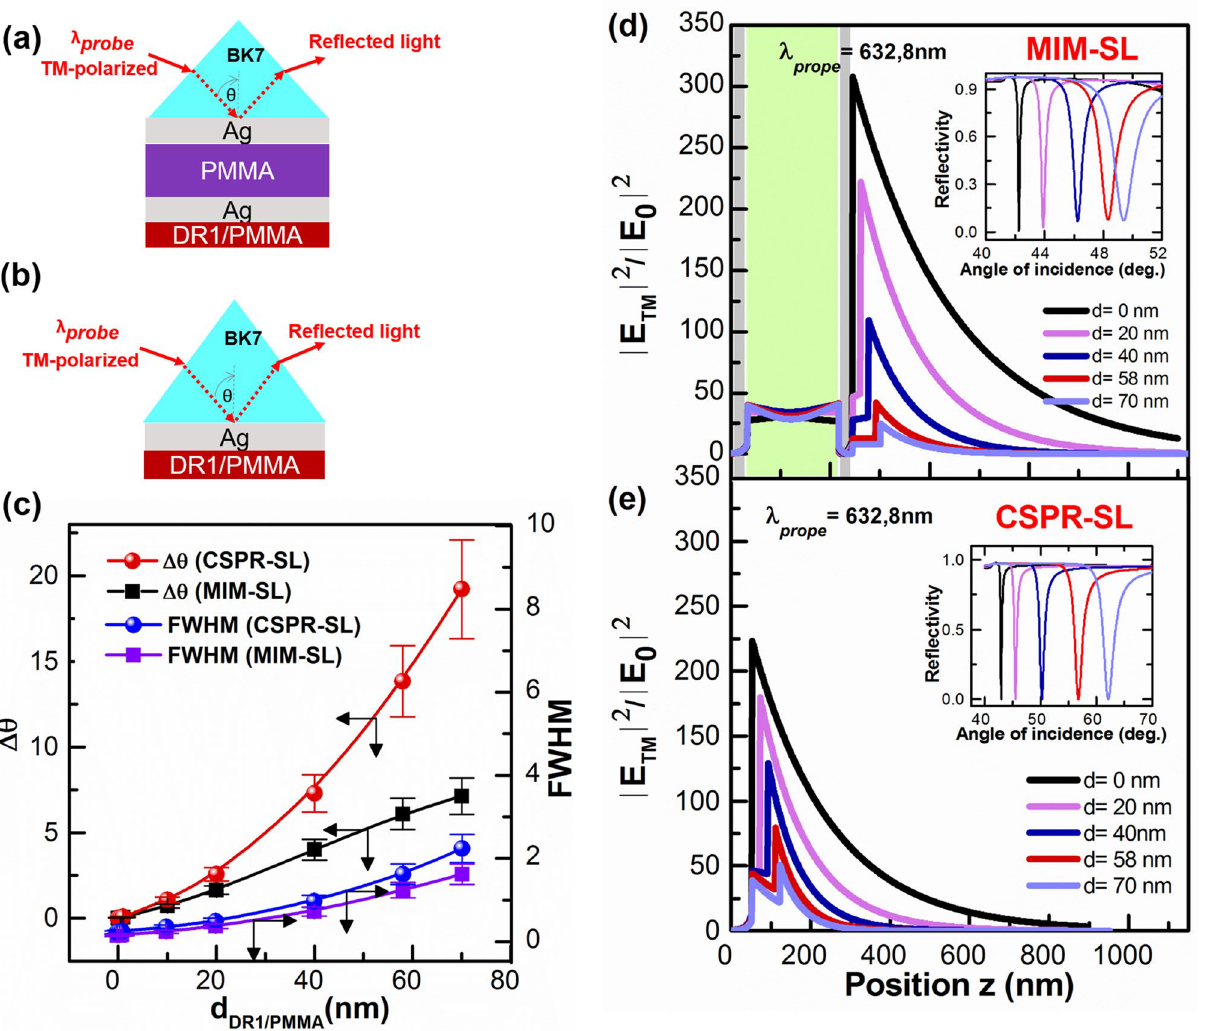
Figure 2.. ( a , b ) schematic of the MIM and CSPR structures, ( c ) mode shift and FWHM dependence on the thickness of the sensing layer (SL) for both structures; ( d, e ) Electric field profiles calculations for different thicknesses of the sensing layer (SL) at ( d ) the sharp MIM mode and ( e ) the CSPR mode. The insets of ( d , e ) are ATR θ -scan broad dip versus the sharp dip. In particular, the field enhancement is ~ 60 times larger at the Ag/air interface for the sharp versus the broad dip, and consequently, the sharp resonance mode, with its substantially enhanced evanescent wave in air, can be used for sensing applications 47,49 . While the suitability of this mode was proven for bulk sensing 12,13 , this paper aims to assess its capabilities for thin film sensing , and therefore only the sharp mode of the MIM structure is considered for the comparison with the well-established CSPR thin film sensing 27,50 . For thin film sensing, an adsorbate layer, i.e. the SL, is deposited on top of the structure; a feature which disturbs the field distribution (FD) and changes field enhancement (FE) at the structure and, consequently, they need to be recalculated. Figure 2 shows the results of EM calculations of the field distribution and field enhance- ment for both the MIM and CSPR structures when a sensing layer is deposited on top of the structure . The inset to Fig. 2d and e show θ -scan ATR spectra of the sensor (MIM for (d) and CSPR for (e)) for different thicknesses of the SL, and the thicker the SL, the larger the mode shift. These figures also show that the FE at the Ag/air interface is larger for MIM versus CSPR without the SL ( d = 0 ) , i.e. by a factor of ∼ 1, 4 . The field enhancement of MIM starts diminishing compared to that of CSPR for thicknesses of the SL around 40nm . Furthermore, the comparison of the resonance dip shift (�θ) of the two structures (Fig. 2c) demonstrates that �θ of CSPR is higher than that of MIM for thicknesses exceeding 10nm . Figure 2c also shows the evolution of the FWHM of the sharp MIM and CSPR modes as the thickness of the SL increases. FWHM of both structures is comparable for the same thickness of the sensing layer (SL), with a noticeable, i.e. small, difference at larger thicknesses. According to our detailed studies (summarized in Supporting Information), in the absence of coupling, i.e. for an uncoupled MIM structure having a semi-infinite outer metal layer, the S-SPP mode stays at the same position ( 52.81 ◦ ), while the Ag/Air (or Ag/SL/Air) mode shifts from 42.78 ◦ to 62.51 ◦ as the SL thickness increases from